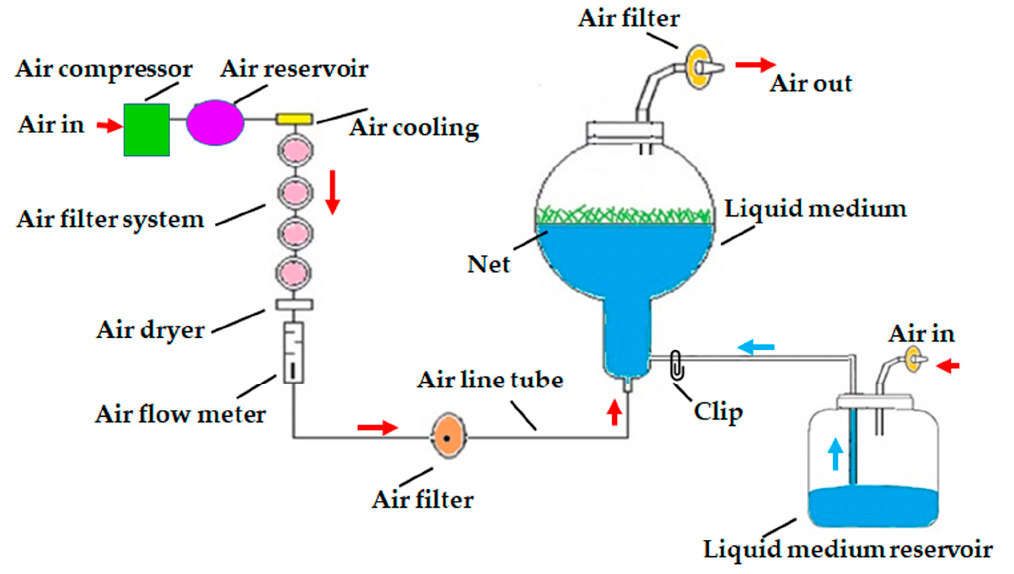
Figure 6. Schematic diagram of air-lift continuous immersion liquid culture system utilized for axillary cladode proliferation of H. polyrhizus using cladode segments. Red arrow = supplement of air, blue arrow = supplement of liquid medium.